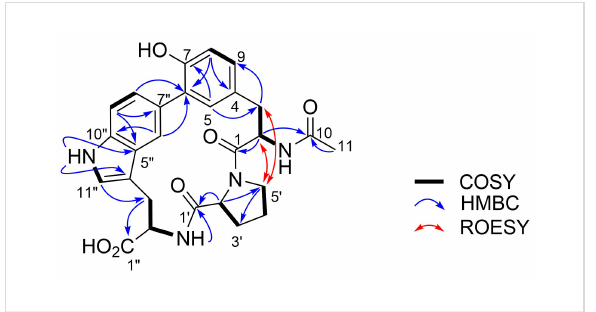
Figure 2: COSY, key HMBC and ROESY correlations of pseudo- sporamide ( 1 ).